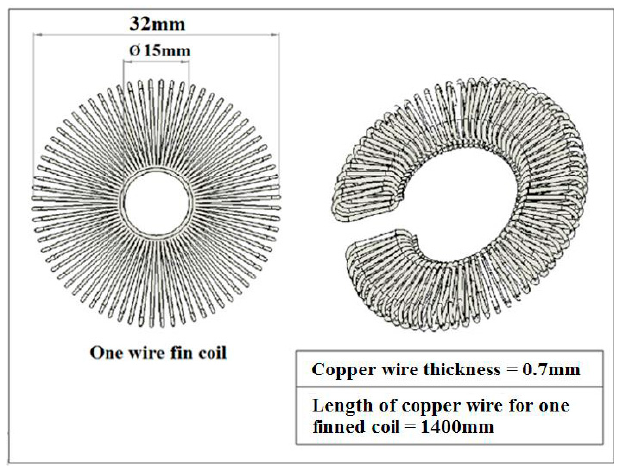
Figure 21. Drawing dimension for copper wire woven finned heat exchanger used to generate volume and surface area of the fin.